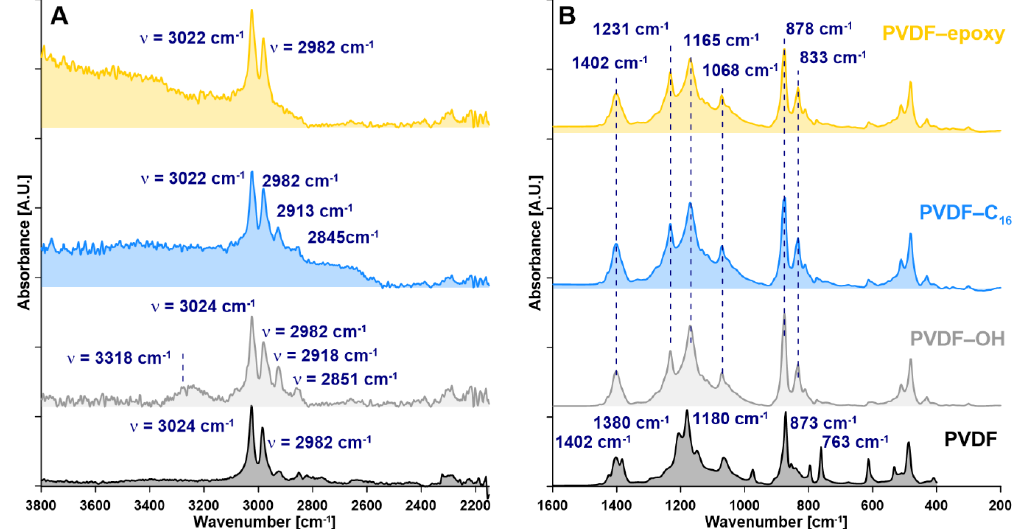
Figure 4. FTIR-ATR spectra of the investigated samples, ( A )—spectra in the range of 2200–3800 cm − 1 , ( B )—spectra in the range of 200–1600 cm − 1 .